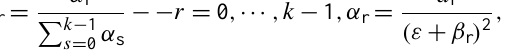
(c) bund collapse